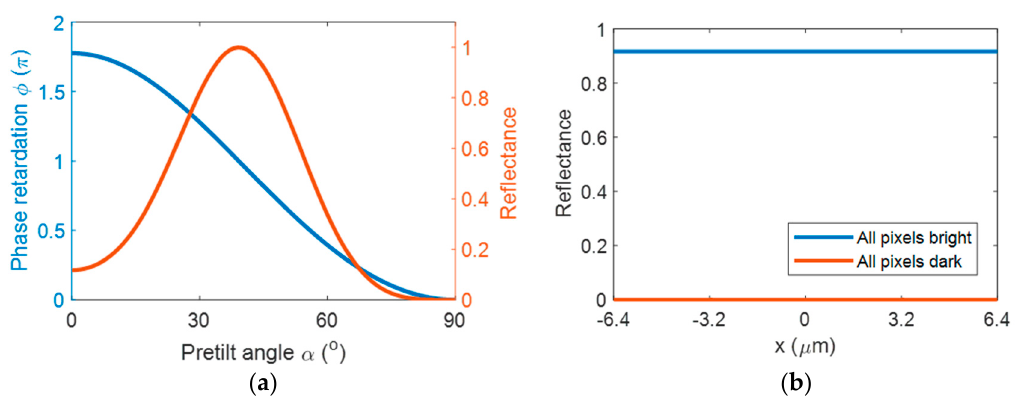
Figure 9. ( a ) The pretilt angle dependent phase retardations. ( b ) Spatial phase retardation uniformity at voltage-off